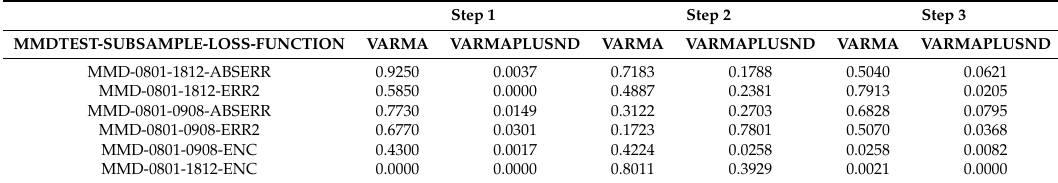
Figure 11. Graph showing the p -values of the Harvey heteroskedasticity test for the VARMA model using both hard and soft data for non-durable goods. The null hypothesis states that the residuals are not heteroskedastic. Table 4. Tests of equal predictive accuracy and test of forecast encompassing of VARMA using only hard data and both hard data and soft data, respectively (i.e., ISTAT survey), for non-durable goods. The forecast window expands itself from 2008:01 to 2018:12. The three tests are considered at the end of the sample and at the maximum value of forecast benchmark, i.e., August 2009. The p -values near to one show that the null hypothesis of equal predictive accuracy have been accepted with respect to the benchmark of Bulligan et al. For encompass test, the null hypothesis is that the forecast of the benchmark encompasses the forecast of the